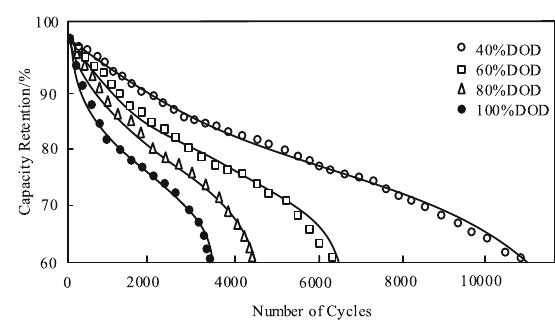
Fig. 1 Battery capacity retention under different